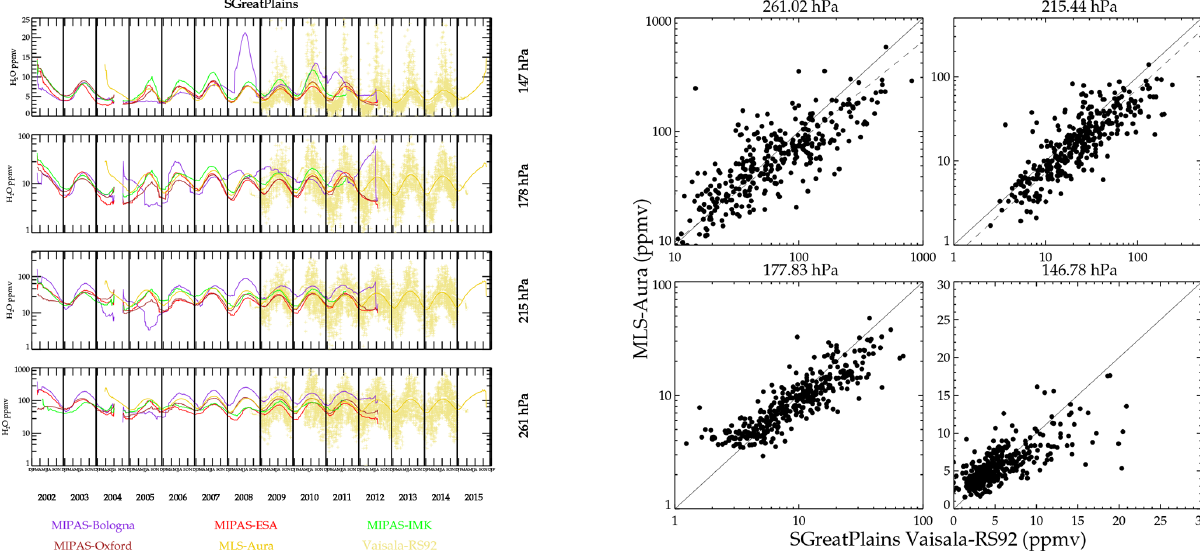
Figure 15. Smoothed time series (left) and scatter plot (right) comparing Vaisala RS92 hygrometer versus satellite instrument and retrievals at Southern Great Plains, USA.